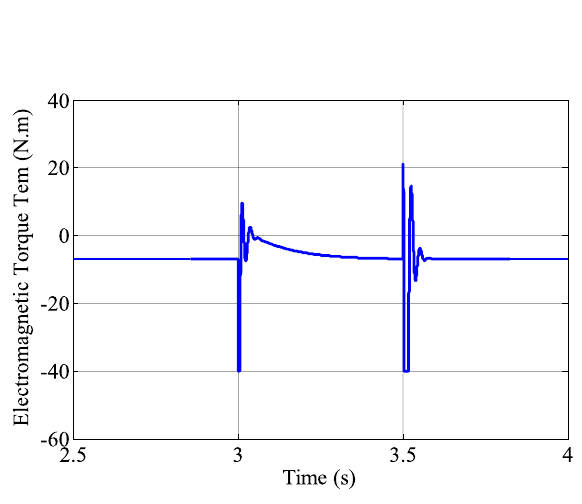
Fig. 7 Electromagnetic Torque T em en